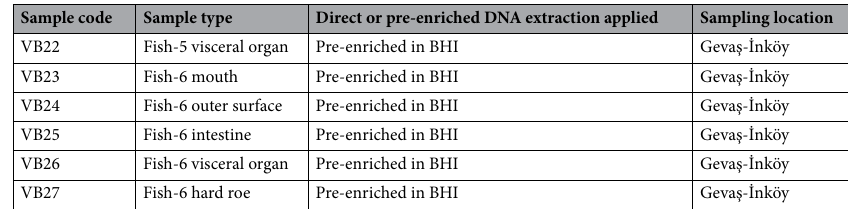
Table 1. Sample types collected from different locations in Lake Van and studied in NGS analysis.